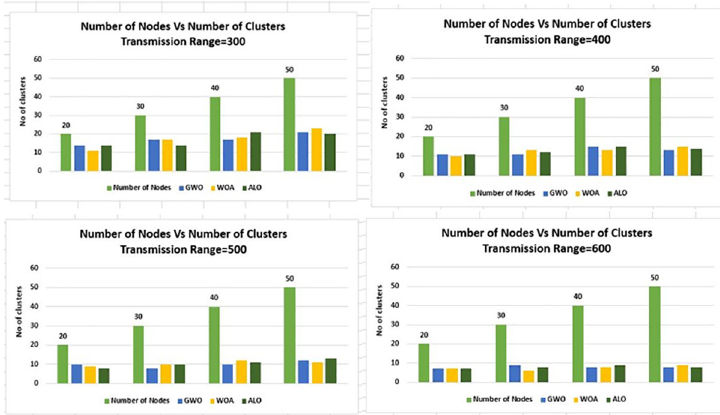
Fig 11. Node density versus number of clusters for transmission range 300m-600m & grid 2Km × 2Km.